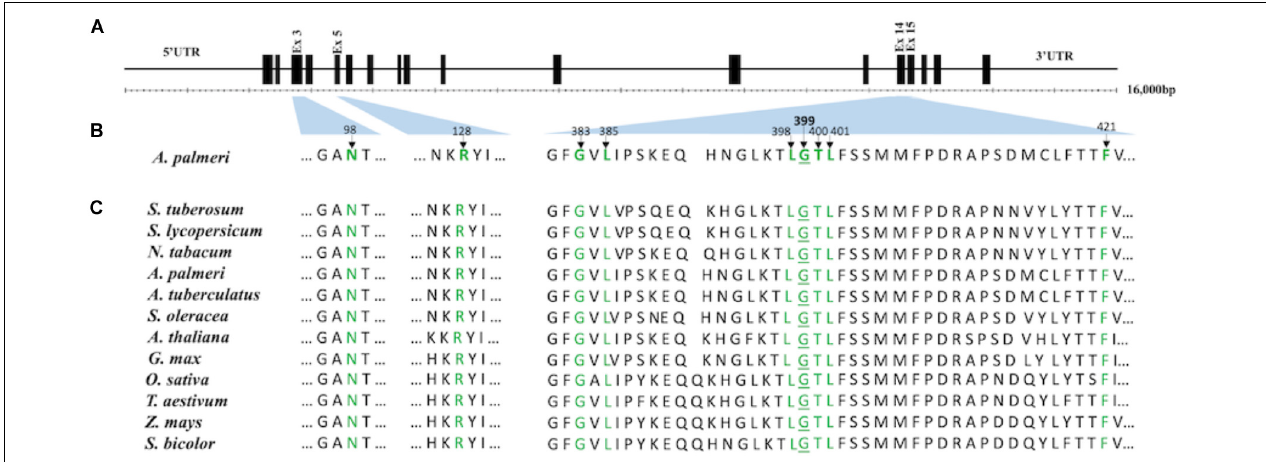
FIGURE 1 | Representation of conserved amino acids in the catalytic domain of PPO2 protein of A. palmeri and its corresponding location in the PPO2 gene (A) . Schematic map of the reference PPO2 gene from A. hypochondriacus (EU024569). The gene length and location of exons (black box) are drawn to scale. The gene has 18 predicted exons. Thin lines represent 5 (cid:48) UTR, introns and 3 (cid:48) UTR. (B) Graphical representation of the positions of conserved amino acids (highlighted in green) in the PPO2 protein of A . palmeri . The location of corresponding genetic code is shown by the light blue-shaded area between the PPO2 gene (A) and protein sequence (B) . The following amino acids are believed to be involved in substrate or inhibitor binding, as deduced from the crystal structure of N. tabacum PPO2 protein: Asn67, Arg98, Gly354, Leu356, Leu369, Gly370, Tyr371, Leu372, and Phe392 (Koch et al ., 2004). Their corresponding loci in A . palmeri are Asn98, Arg128, Gly383, Leu385, Leu398, Gly399, Tyr400, Leu401, and Phe421. The difference in numbering with respect to N. tabacum is due to the presence of 30 amino acid signal peptide extension at the N terminal of PPO2 in A. palmeri . Amino acid numbering is based on A . Palmeri (ATE88443) starting at methionine. (C) Alignment of the PPO2 amino acid sequence spanning the catalytic domain among different plant species. PPO2 protein sequences from Solanum tuberosum (CAA1240 1), S. lycopersicum (NP_001335305), S. oleracea (BAB60710), Glycine max (NP_001236376), Arabidopsis (NP_196926 ), A. Palmeri (ATE88443 ), A. tuberculatus (ABD52329), N. tabacum (BAA34712), Oryza sativa (XP_025880545), Triticum aestivum (SPT18865) , Zea mays (NP_001105004), and Sorghum bicolor (XP_002446710) were aligned using CLUSTAL-W (https://www.genome.jp/tools/clustalw).